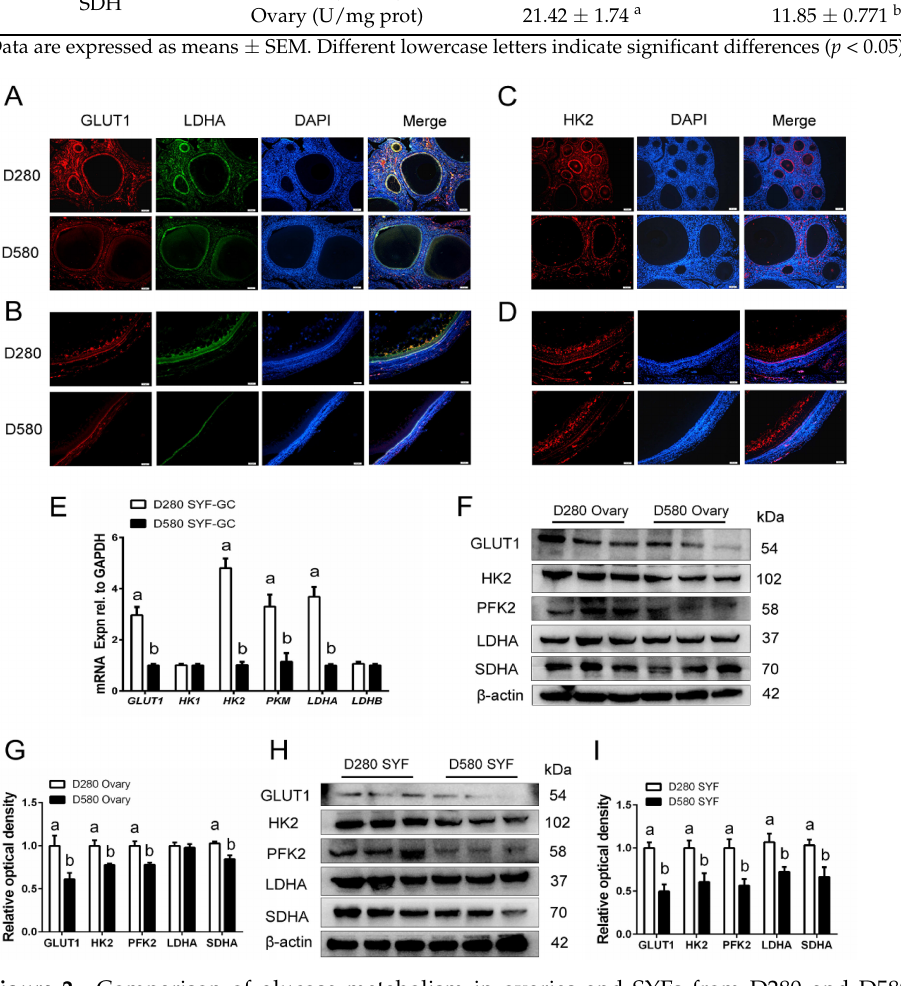
Figure 2. Comparison of glucose metabolism in ovaries and SYFs from D280 and D580 hens. ( A , B ) Histological sections of ovarian tissues and SYFs (D280 and D580) were given immunofluores- cent labels with GLUT1 (red) and LDHA (green), showing the main distribution in the granulosa layer. Scale bar: 50 µ m. ( C , D ) Immunofluorescence staining for HK2 in the ovaries and SYFs of hens aged D280 and D580 days. Scale bar: 50 µ m. ( E ) Quantitative RT-PCR for GLUT1 , HK1 , HK2 , PKM